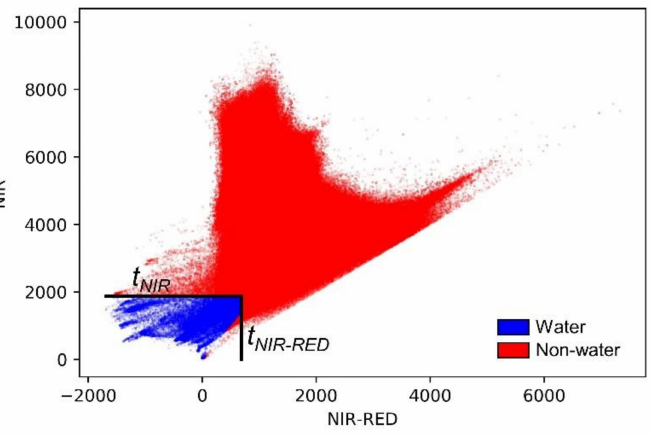
Figure 4. GWP classification feature space. Data: MODIS Terra h17v07,